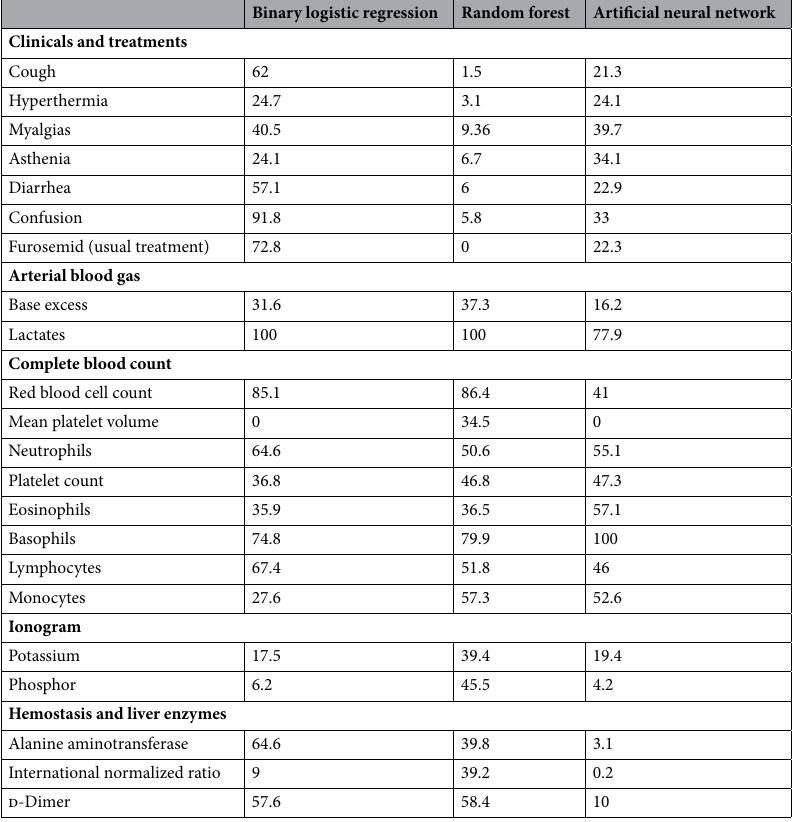
Table 4. Importance of clinico-biological variables by decreasing order in each model type. The relative importance of each variable was calculated in comparison with the most important variable in the model, whose importance was arbitrarily set at